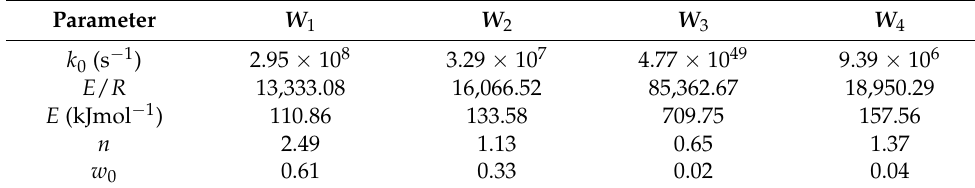
Overall adjustments of the four heating